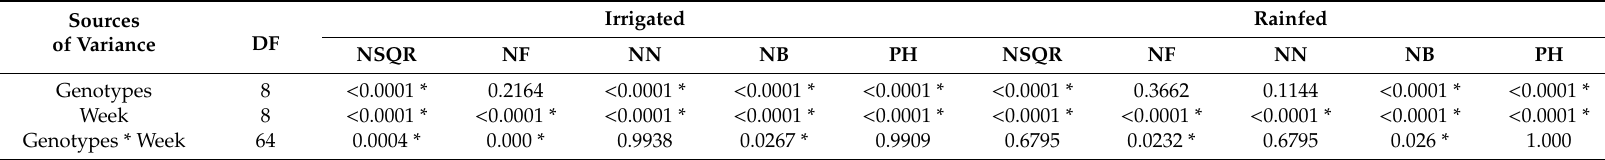
Table 1. Analysis of variance for the number of bolls (NB), number of squares (NSQR), number of flowers (NF), plant height (PH), and number of nodes (NN) for upland cotton lines grown under irrigated and rainfed conditions. DF—degrees of freedom.